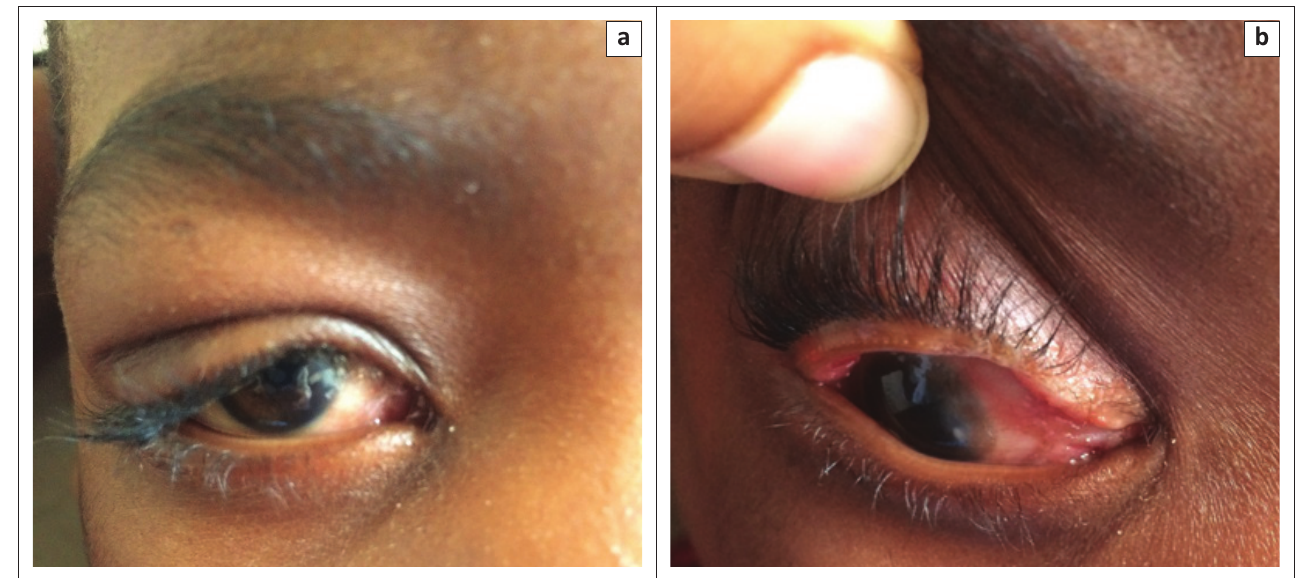
FIGURE 3: (a) Marked clinical improvement on TB treatment and (b) corneal scarring from a healed